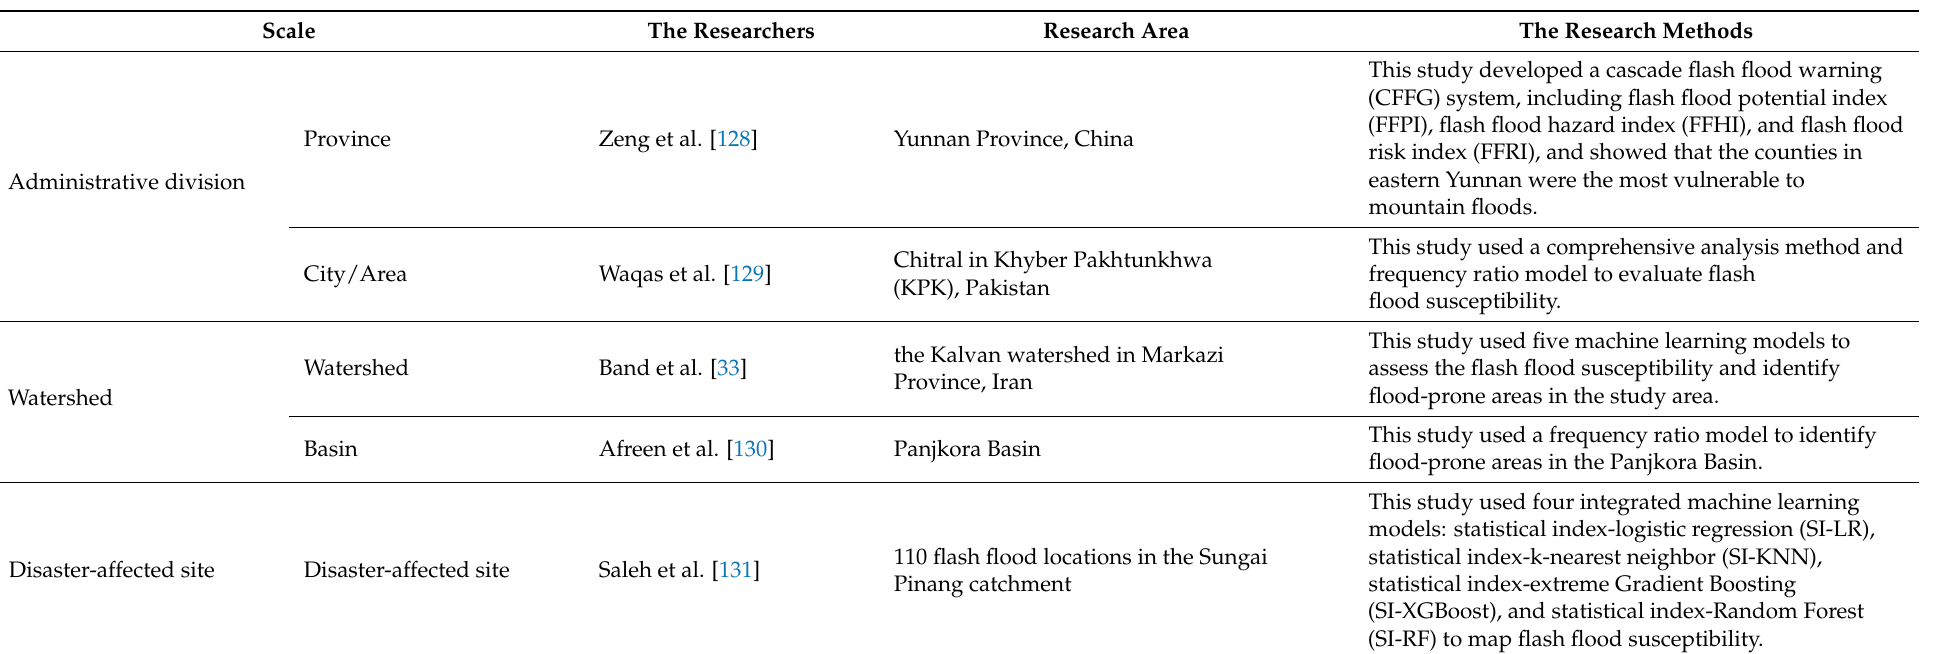
Table 6. Assessment